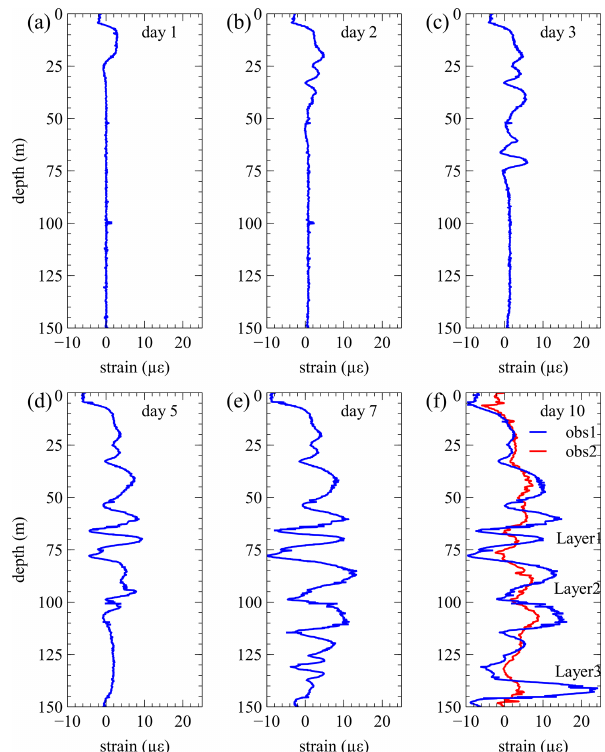
Figure 5. Strain profiles along obs1 well on different days. The strain profile of obs2 at day 10 is added in (f) for comparison. The time series of the strain changes for the three arrows refer to depths shown in Fig.